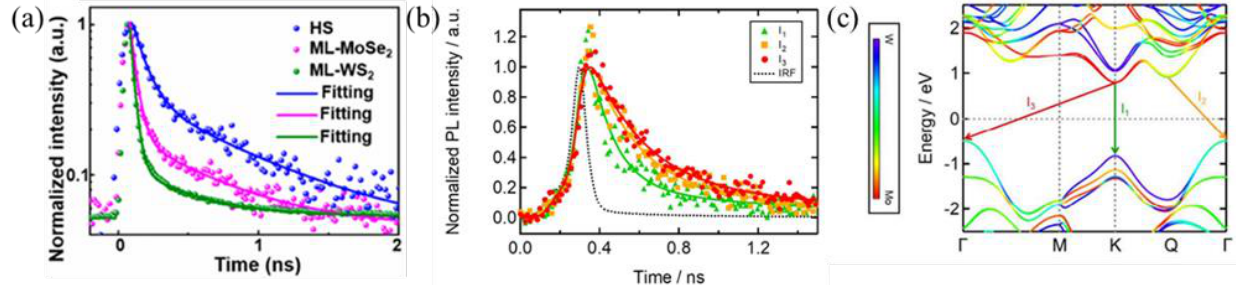
Figure 6. ( a ) Time-resolved PL decay curves for MoSe 2 monolayer, WS 2 monolayer, and WS 2 /MoSe 2 Hs. Reprinted with permission from Ref. [40]. Copyright 2021, American Chemical Society. ( b ) Time-resolved PL intensity of hBN/WS 2 /MoS 2 /hBN [87]. ( c ) DFT band structure of WS 2 /MoS 2 Hs [87]. Reprinted with permission from Ref. [87]. Copyright 2018, American Chemical Society.